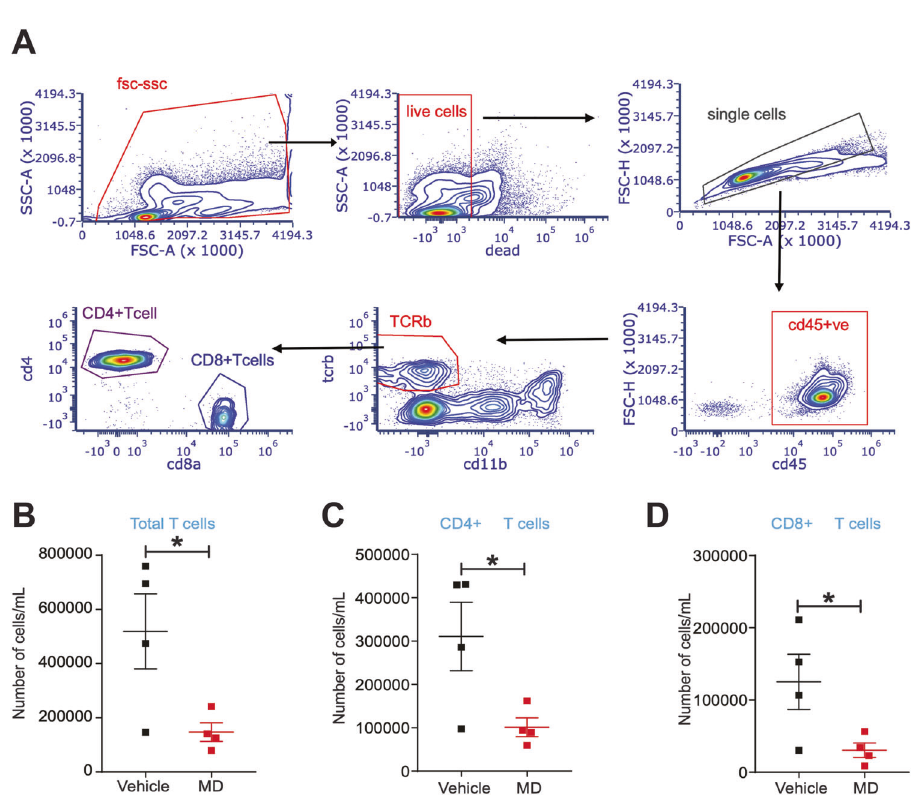
Fig. 6 Gut microbiota depletion affects total, CD4 + and CD8 + T cell population in the peritoneal fl uid from mice with endometriosis. A Flowchart of Flow cytometric plots for the cell sorting using Cytek. B - D The relative number of B total T cells per mL, C CD4 + T cells per mL and D CD8 + cells per mL in the peritoneal fl uid from vehicle and MD mice. The endometriosis was induced in the vehicle and MD mice as shown in Fig. S1B and fl ow cytometric analysis was carried out on the peritoneal fl uid 21 days after the induction of endometriosis. Data are presented as mean ± SE ( n = 4), * P < 0.05.